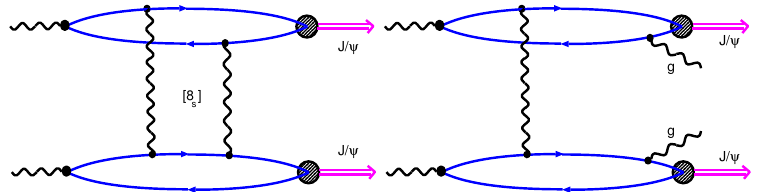
Figure 4. Production mechanisms of J /ψ -pairs involving t -channel gluon exchanges in the color-singlet model. Left: quasidi ff ractive exchange of two gluons in a symmetric color octet. Right: single gluon exchange with radiation of additional gluons from the quark